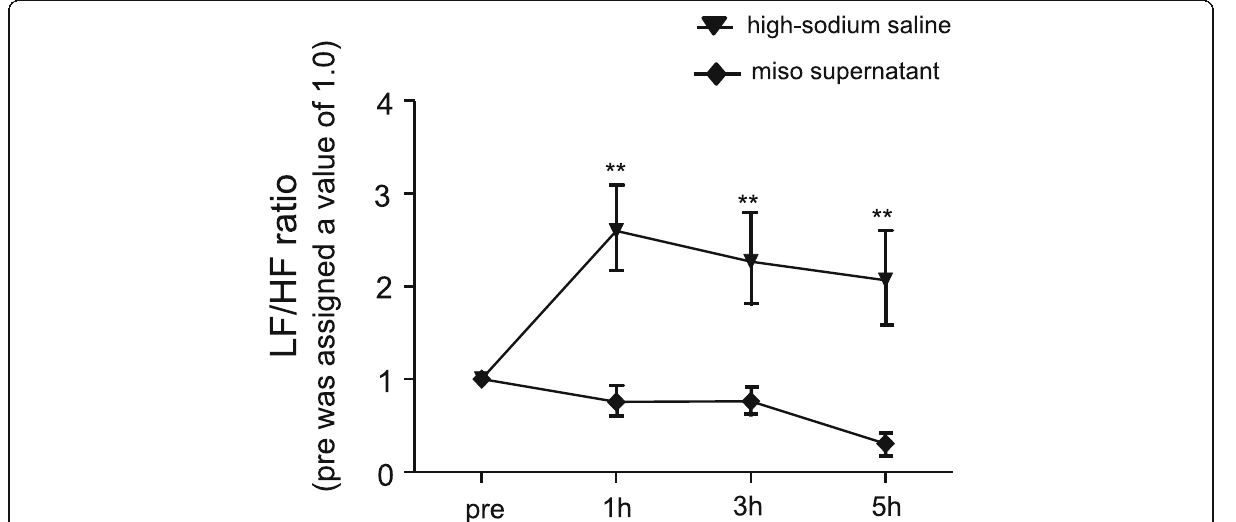
Fig. 5 LF/HF ratio in CPO-mice evaluated via ECG. The LF/HF ratio before the injection was assigned a value of 1.0. n = 5 for each. ** p < 0.01 high-sodium saline versus miso supernatant. LF, low frequency power of heart rate variability; HF, high frequency power of heart rate variability